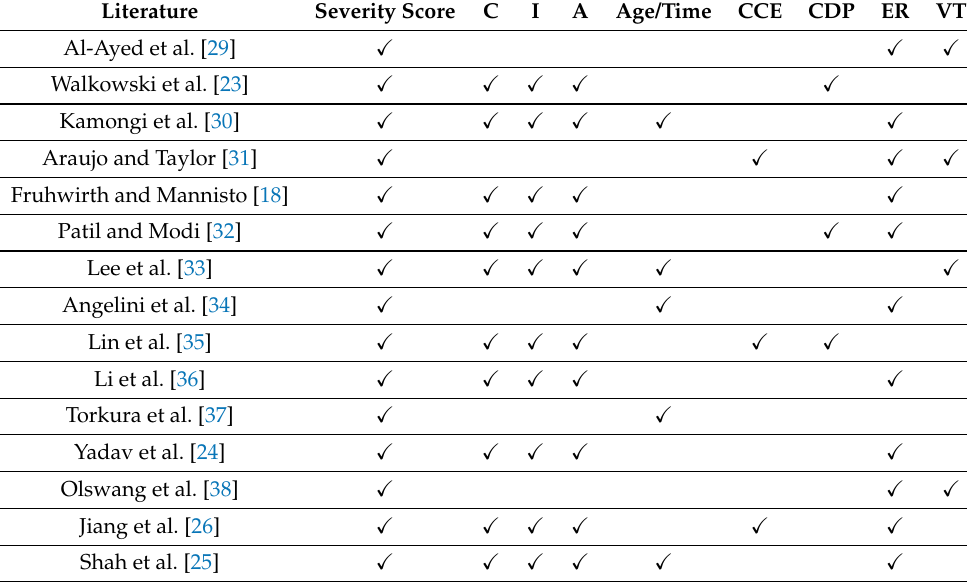
Table 2. The evaluation criteria in related